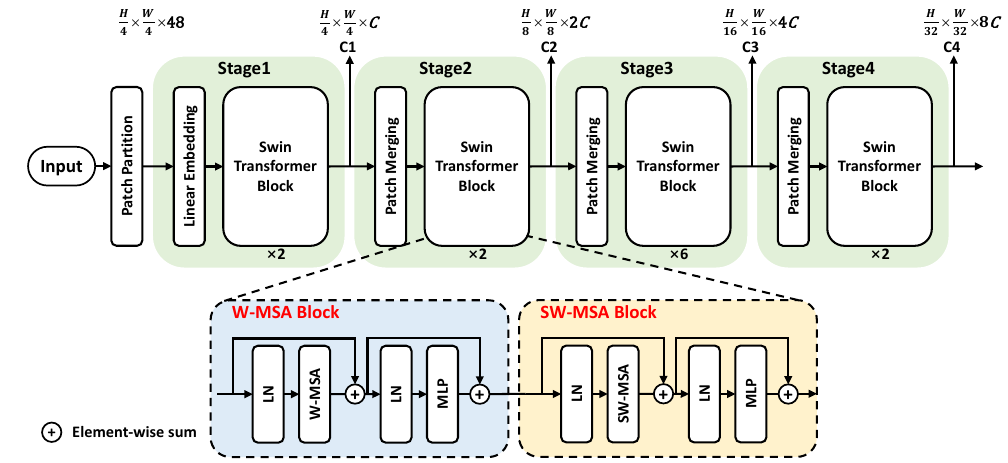
Figure 2. The overall framework of the Swin transformer